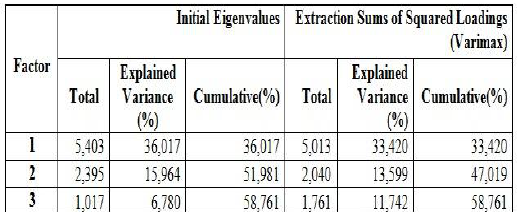
Table 3: Variance Description of the Scale of Consumer Perception on Guerrilla Marketing Methods (SCPGMM)